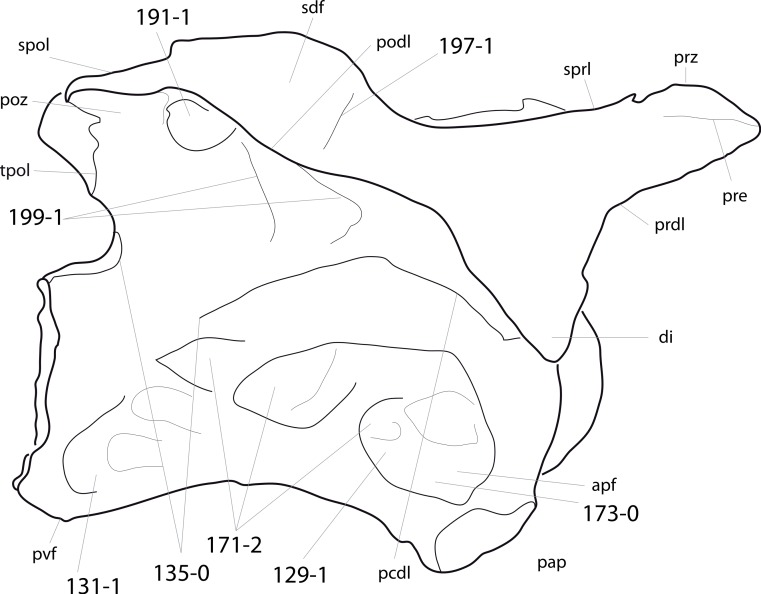
Mid-cervical vertebra (CV ?10) of Galeamopus sp. SMA 0011 in right lateral view.Note the pleurocoel typical for advanced eusauropods (C129-1), but highly subdivided (C171-2), the elongate posteroventral fossa present in diplodocines (C131-1), the anteriorly restricted pcdl (C135-0), in contrast to the more posteriorly reaching pcdl of Apatosaurus, the dorsally excavated parapophysis (C173-0), the large foramen connecting the pocdf and the spof (C191-1), and the accessory laminae connecting the podl and the sprl (C197-1), and the pcdl and the podl (C199-1). Abb.: apf, anterior pneumatic fossa; di, diapophysis; pap, parapophysis; pcdl, posterior centrodiapophyseal lamina; pocdf, postzygapophyseal centrodiapophyseal fossa; podl, postzygodiapophyseal lamina; poz, postzygapophysis; prdl, prezygodiapophyseal lamina; pre, pre-epipophysis; prz, prezygapophysis; pvf, posteroventral flange; sdf, spinodiapophyseal fossa; spof, spinopostzygapophyseal fossa; spol, spinopostzygapophyseal lamina; sprl, spinoprezygapophyseal lamina; tpol, interpostzygapophyseal lamina.